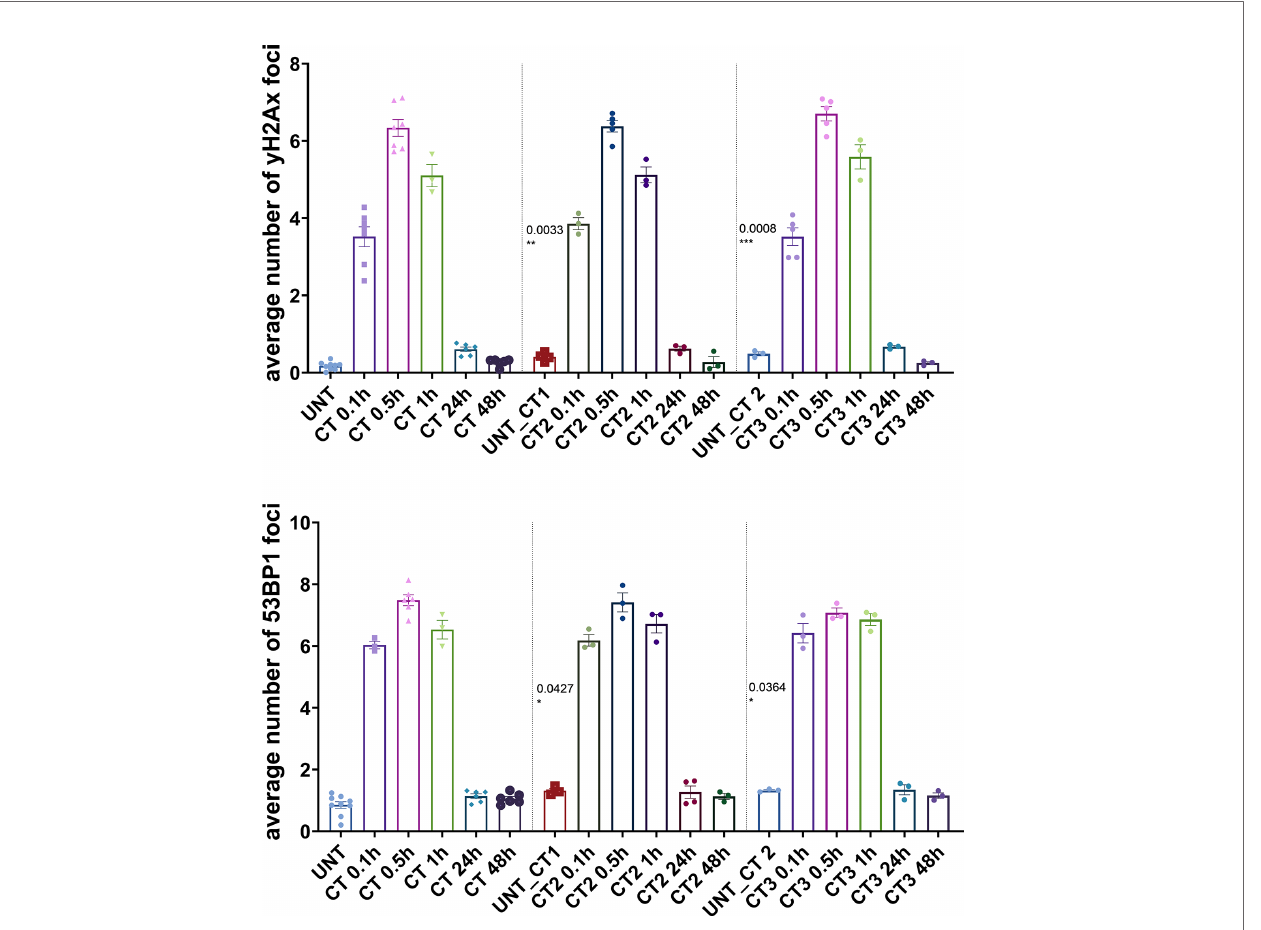
FIGURE 2 | Immunocytochemical analysis of repair foci after repeated CT scans in MCF10A cells. Evaluation of g H2AX foci (top) and 53BP1 foci (bottom) after systematic diagnostic CT scans with ~20 mGy per round (in total three rounds) using conventional fl uorescence microscopy (Leica DMI6000B). Data are presented as bar plots of average foci number (+/ − SEM) per cell per experiment from at least three independent experiments (UNT, untreated values with included “ age- matched ” controls; CT1, 1st round of computed tomography; CT2, second subsequent diagnostic CT; CT3, third subsequent diagnostic CT; p values on graph represent comparison to UNT; SEM, standard error of the mean). *P ≤ 0.05 , **P ≤ 0.01, ***P ≤